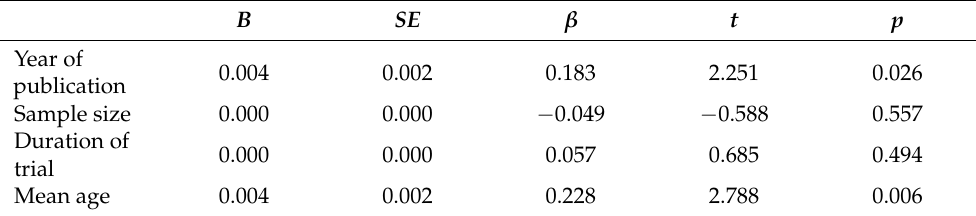
Table 3. Linear regressions